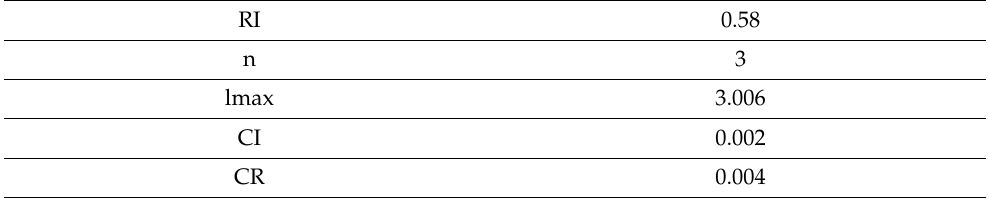
Table 6. Variables used for consistency ratio of vulnerability